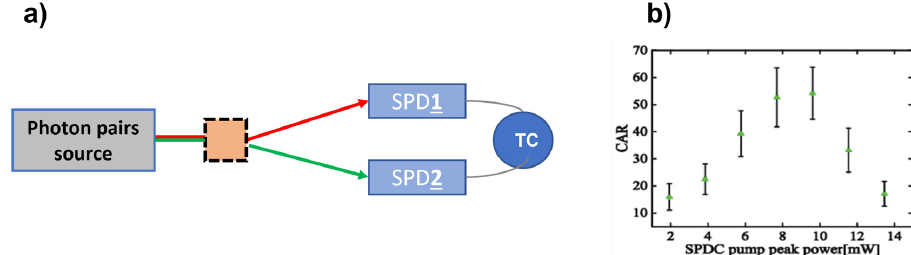
Figure 3. ( a ) Schematic of the typical setup implemented for the coincidence measurement. It consists of a component (orange square) for the spatial separation of signal and idler photons, two single photon detectors (SPD1, SPD2) and time controller electronics (TC) to record the difference in the arrival time of the photons; ( b ) An example of the typical trend of the CAR as a function of the pump peak power. Reproduced with permission from [38], copyright 2017. The signal and idler photons generated through the non-linear process are spatially separated using a specific component (graphically represented by the orange square), for example a dichroic mirror [38], a parabolic mirror for far field separation [39], or a polar- izing beam splitter, according to the specific experimental set up. The signal and idler photons are then detected by two single photon detectors. Time-tagging electronics is used to record the difference in their arrival time and build a coincidence plot, showing the coincidence counts as a function of the arrival time difference of the signal/idler pho- ton on the detectors. At zero time difference a coincidence peak is expected to demonstrate the generation of the photon pair. The true coincidence counts result from the simultane- ous detection of the photon pair generated by the same pump pulse, corresponding to the coincidences in the zero-delay peak. It is linearly dependent on the pump power. The ac- cidental coincidence is the rate of coincidence not resulting from the detection of both photons from a single pair, but from uncorrelated photons from two different SPDC pro- cesses. It depends quadratically on the pump power. The signal-to-noise ratio in coincidence measurement is referred to as coincidence to accidental ratio (CAR). It is calculated using the coincidence plot as the number of coinci- dences in the peak within a certain coincidence window ( N 12 ) divided by the average of the background counts on the same time window taken away from the peak ( N acc ): 𝐶𝐴𝑅 = (cid:3015) (cid:3117)(cid:3118) (cid:3015) (cid:3276)(cid:3278)(cid:3278) , (8) The characterization of the CAR for a SPDC process is carried out studying the vari- ation of the CAR as a function of the pump peak power in order to find the best pump power maximizing it. The typical trend is reported in Figure 3b and shows a trade-off behavior with the pump power. For low pump power, the CAR is lower due to the low photon-pair generation which has to be compared with the overall noise and dark count rates of the entire detection system employed. Above a certain threshold the CAR de- creases with the pump power due to the multiphoton pair emission in SPDC, which con- sists in the simultaneous generation of more than one pair (per pulse) that increases the probability of accidental-coincidence detection. 3.2. Purity and Second Order Correlation Function Ideally, a single photon source would emit a single photon every time with zero prob- ability of multiple photon emission. The probability of single photon emission is defined as source purity [37]. The characterization of the source purity is performed measuring the second order correlation function g (2) ( τ ), where τ is the time delay between the idler and signal photons, which quantifies the multiphoton component with respect to the sin- gle-photon component. The experimental set up commonly used to measure g (2) ( τ ) is a modified version of the Hanbury–Brown Twiss interferometer used for the correlation